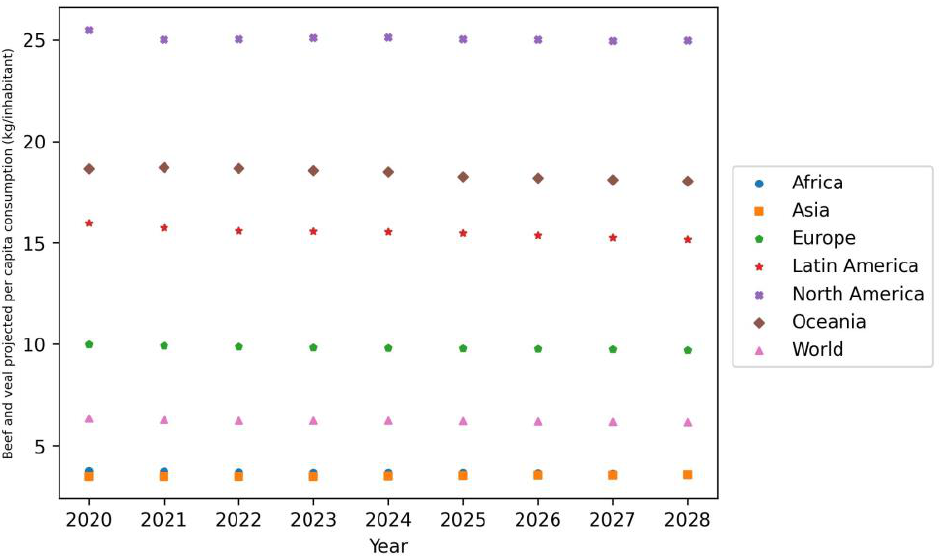
Figure 1. Beef and veal projected per capita consumption in the 2020–2029 period. Source: OECD (2023), Meat consumption (indicator). https://doi.org/10.1787/fa290fd0-en (accessed on 5 January 2023). Per capita consumption expressed in retail weight. Carcass weight to retail weight conversion factors of 0.7 for beef and veal, 0.78 for pig meat, and 0.88 for both sheep meat and poultry